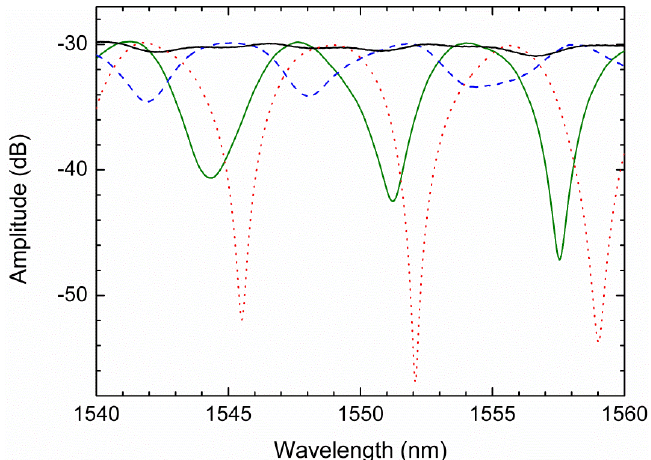
Figure 3. Interferometer spectra obtained for different polarization controller positions.